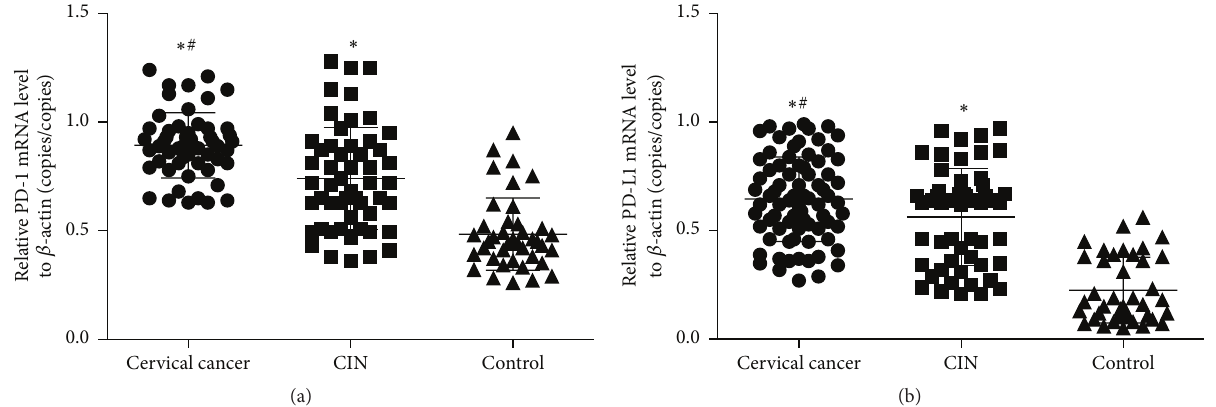
Figure 4: The mRNA expression levels of PD-1 and PD-L1. qRT-PCR was used to measure (a) PD-1 mRNA level and (b) PD-L1 mRNA level in normal control, CIN, and cervical cancer groups. ∗ 𝑃 < 0.05 compared with control group; # 𝑃 < 0.05 compared with CIN